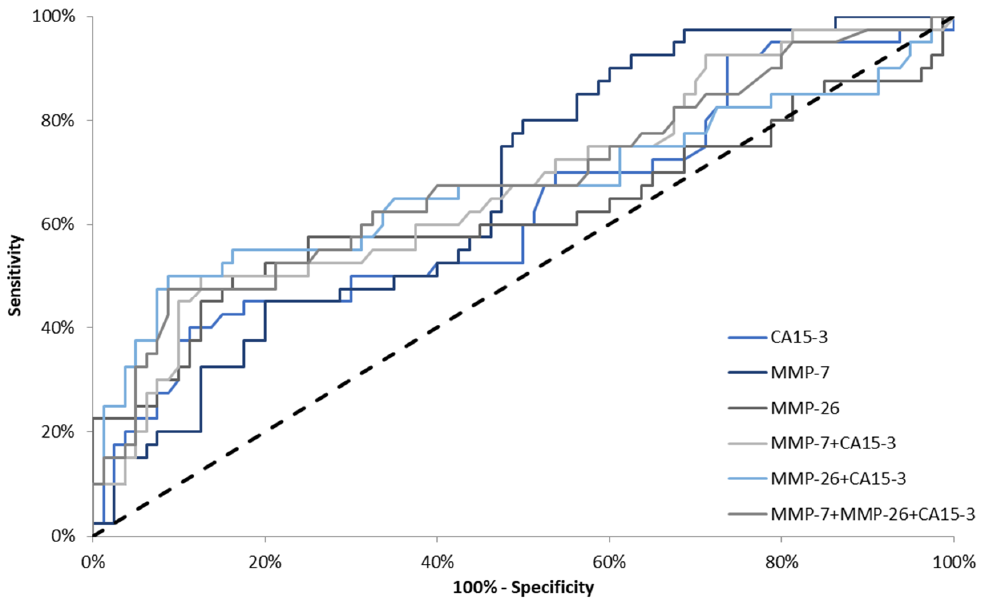
Figure 5. Diagnostic criteria of ROC curve in stage II breast cancer (BC). CA 15-3—cancer antigen 15-3; MMP-7—matrilysin-1; MMP-26—matrilysin-2.